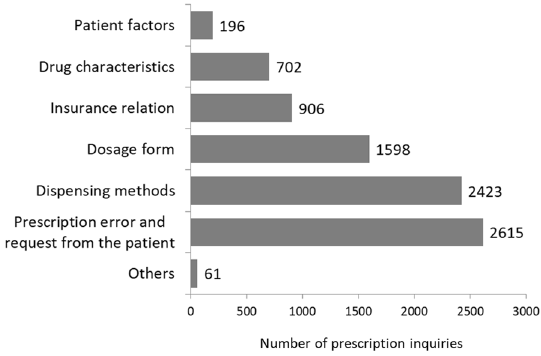
Figure 2. Prescription Inquiries Prior to Listing Laboratory Data on Prescriptions. We categorized prescription inquiries from community pharmacies at baseline (November 2013 through October 2014), before the hospital began to list laboratory data on prescriptions. Patient factors include age, sex, medication history, and past medical history not including laboratory data. Drug characteristics include dose timing and starting dose. Insurance-related inquiries are those concerning payment.